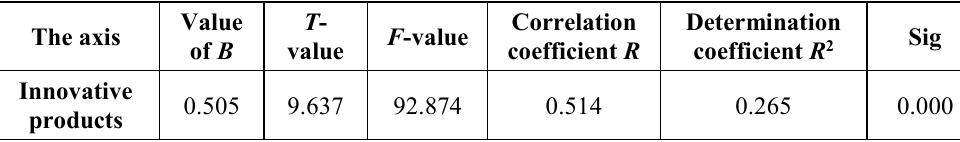
Table 6. Result of Simple Regression Analysis to Test the Impact of Innovative Products on Customer Loyalty T - Determination Correlation Value F -value The axis coefficient R 2 coefficient R value of B